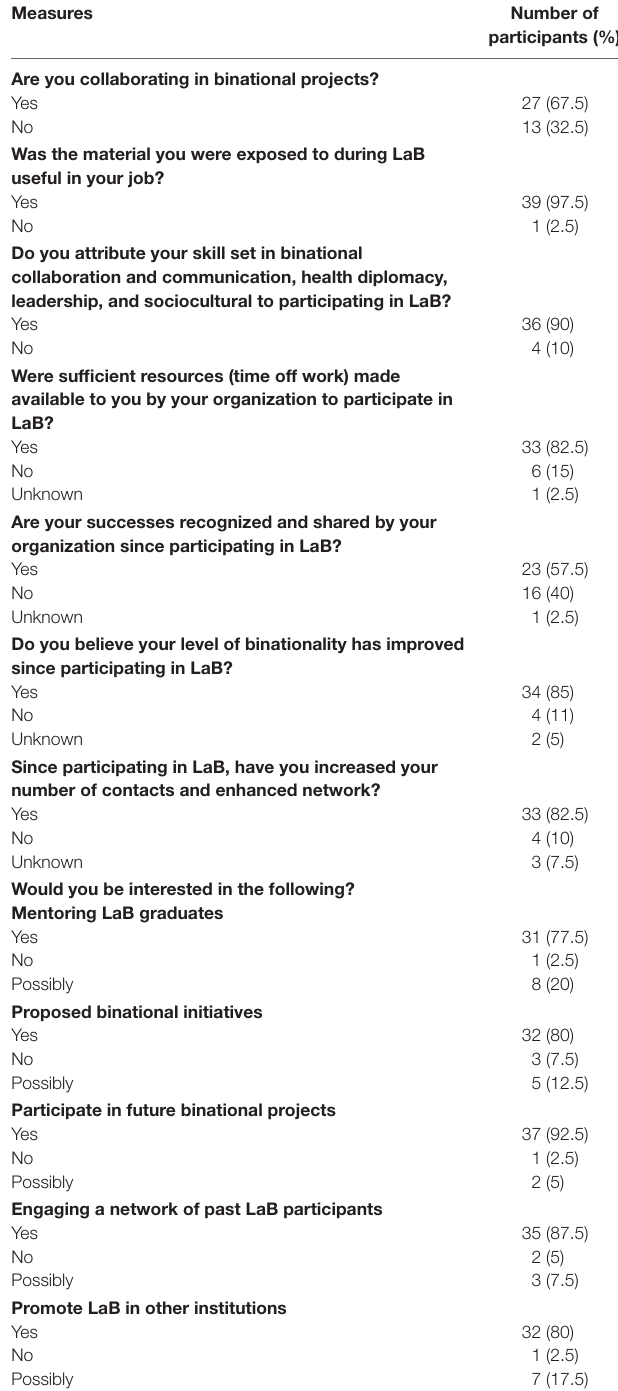
taBlE 3 | Leaders across borders (LaB) program evaluative